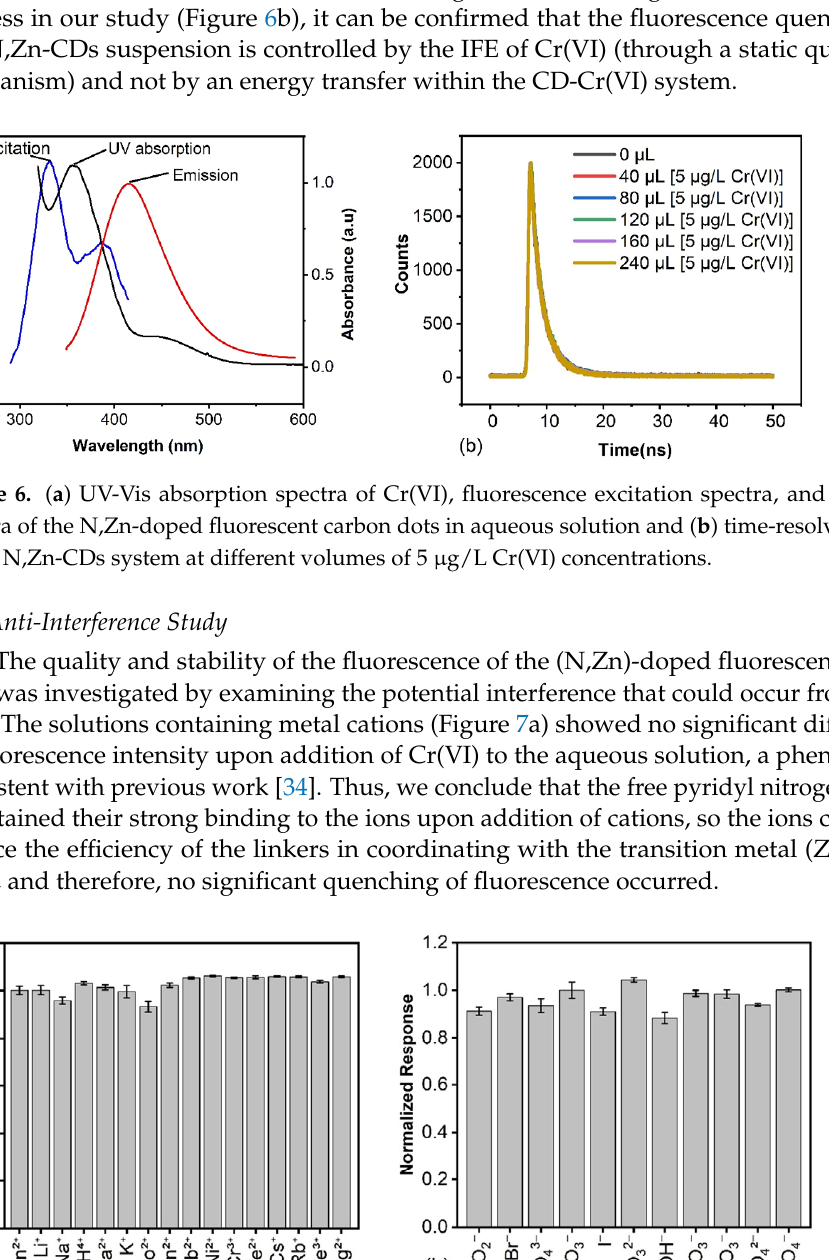
Figure 6. ( a ) UV-Vis absorption spectra of Cr(VI), fluorescence excitation spectra, and emission spec- tra of the N,Zn-doped fluorescent carbon dots in aqueous solution and ( b ) time-resolved decay of the N,Zn-CDs system at different volumes of 5 µ g/L Cr(VI) concentrations.